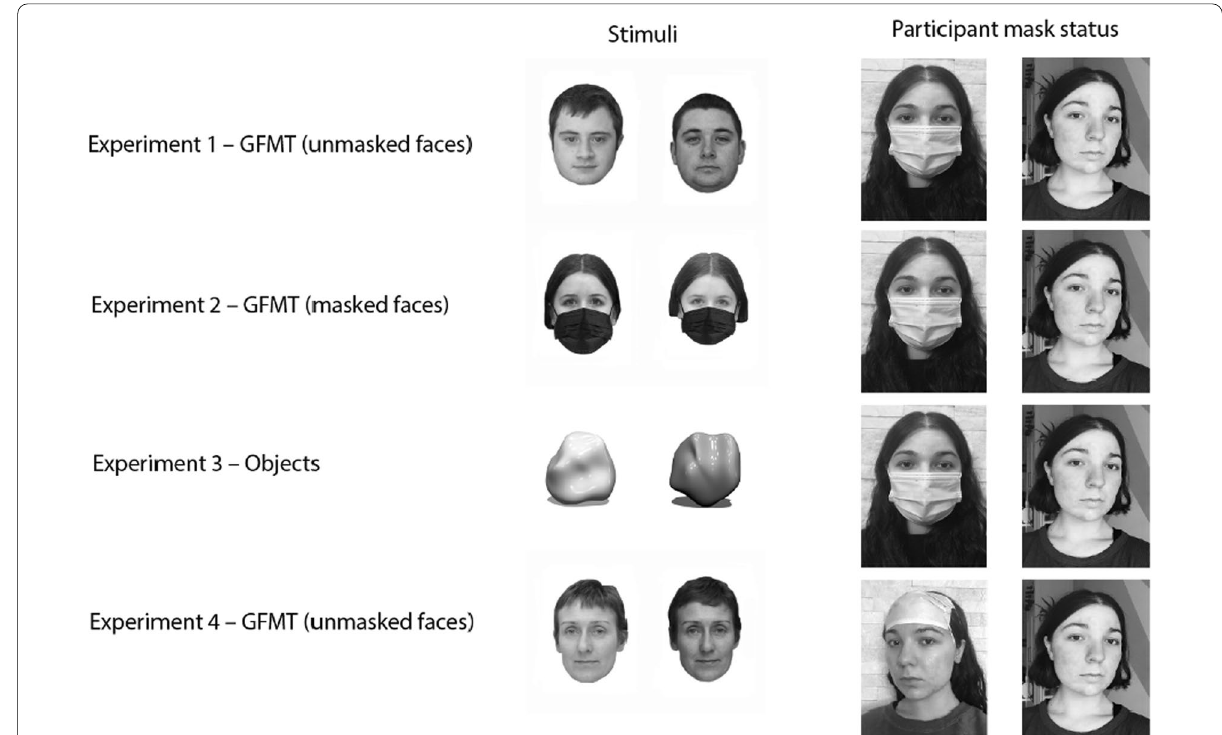
Fig. 1 Experimental stimuli and condition. Examples of the stimuli used in each experiment (left panel), as well as the placement of participants’ masks throughout the experiment (right